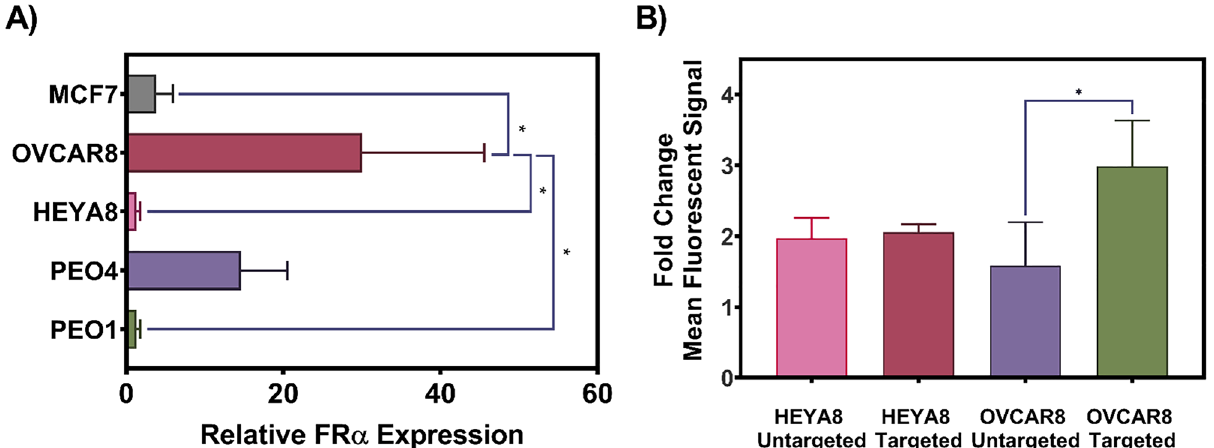
Figure 3. ( A ) Relative FRα expression in the selected panel of OC cell lines with MCF7 (breast cancer cell line) as a negative control and ( B ) Cellular uptake of folate conjugated versus unconjugated fluorescent calcein loaded liposomes. Flow cytometry was used to confirm the relative expression of FRα in the panel of OC cell lines. Data is presented as mean FITC for treated cells divided by the mean FITC for untreated cells, *p < 0.05 (n = 3). Flow cytometry was used to determine the uptake of folate conjugated and folate unconjugated calcein-loaded liposomes in FRα high (OVCAR8) and low (HEYA8) expressing cells, presented as mean FITC values. Data is presented as mean FITC for treated divided by the mean FITC for untreated cells, *p < 0.05 (n = small molecule was identified as a potential active targeting ligand 28 . Per Fig. 3A, surface expression of FRα on the selected panel of OC cell lines was measured by flow cytometry with the breast cancer cell line MCF7 used as a negative control. The OVCAR8 cell line was found to have significantly higher FRα expression compared to both the negative control, HEYA8, and the PEO1 cell line. OVCAR8 was thus selected to evaluate the suitability of our carrier for in vitro cellular uptake. As shown in Fig. 3B, cellular uptake of folate conjugated, fluorescent probe encapsulating liposomes into OVCAR8 cells was significantly greater than unconjugated control liposomes. This effect was not observed in the HEYA8 cell line which does not overexpress surface FRα.